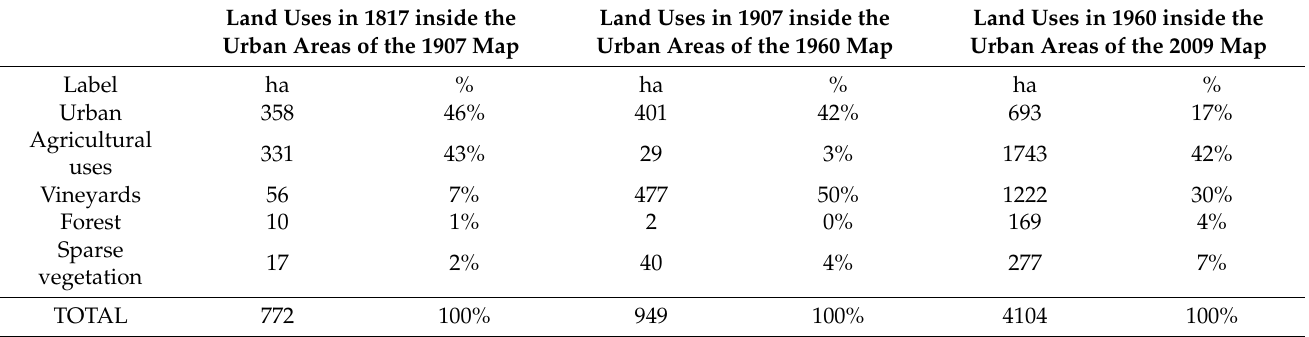
Table 4. Time steps pairwise comparison in urban areas in terms of land use